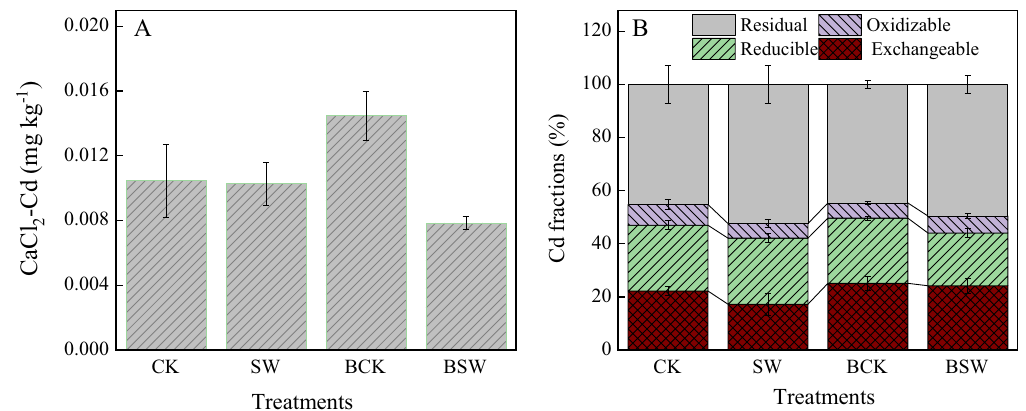
Fig. 1 CaCl 2 ‑Cd concentration ( A ) and the fraction of Cd ( B ) in soils between the treatments. CK: control; SW: soil treated with 1%‑biochar; BCK: soil treated with S. pasteurii ; BSW: soil treated with S. pasteurii and 1%‑biochar. Error bars represent the standard deviation of the means (n